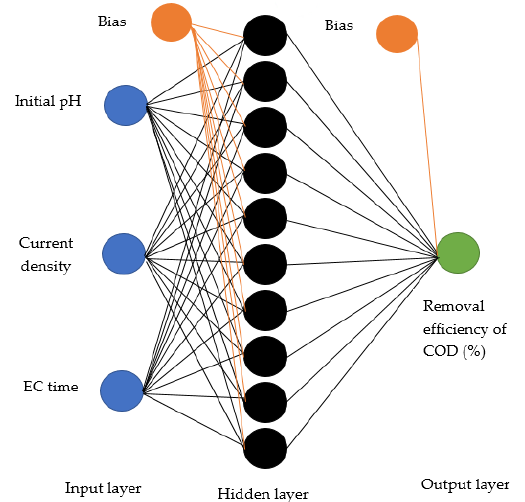
Figure 2. Architecture for the artificial neural network (ANN) model. COD: chemical oxygen demand.